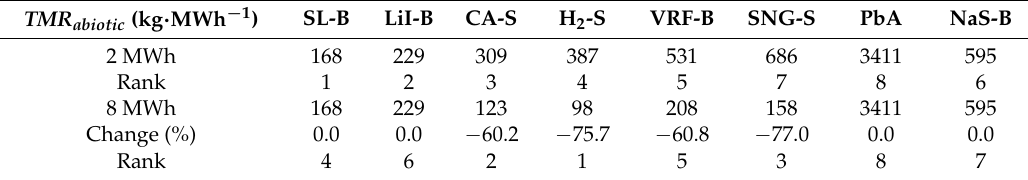
Table A6. Ranking of electrical energy storage technologies for TMR abiotic with 2 and 8 MWh storage capacity.